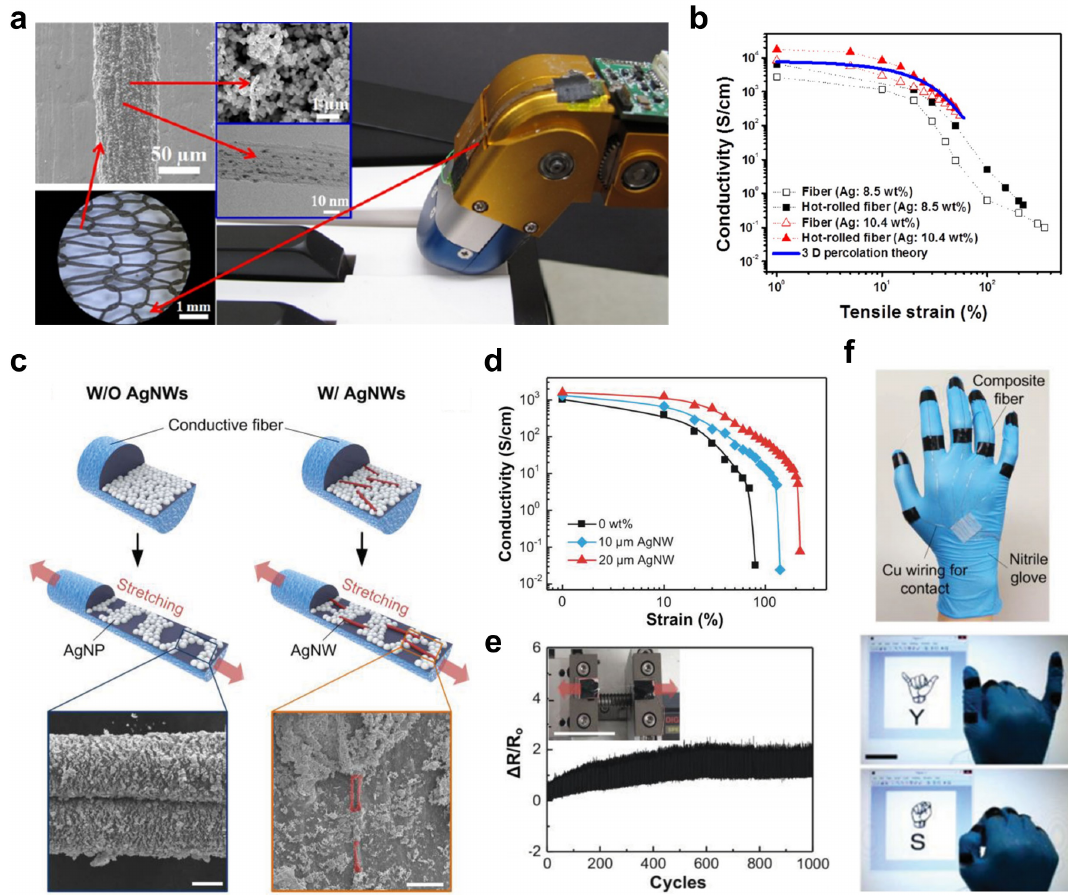
Figure 8. ( a ) FE-SEM and HRTEM images of knitted fabrics made from highly-conductive stretchable fibers. Bottom of this image shows an optical image of 2 ply rope. The knitted fabric was attached to a robot finger (as shown by arrow) for touch sensing; ( b ) Plot shows the conductivities of fibers as a function of tensile strain; ( c ) Schematic illustration of silver nanowires (AgNWs) and silver nanoparticles (AgNPs) in the composite fiber. (Left bottom image in navy colour line: SEM image of AgNP-mixed styrene-block-butadienstyrene (SBS) fiber without AgNWs at 50% strain and and Right bottom image in red colour line: SEM images of the AgNW-AgNP embedded SBS fiber at 50% strain); ( d ) Changes in conductivity of the composite fiber depending on the length of the AgNWs; ( e ) Reliability test measured the changes in the normalized resistance of the composite fiber; ( f ) Photograph of a smart glove made with composite fibers and motion detection